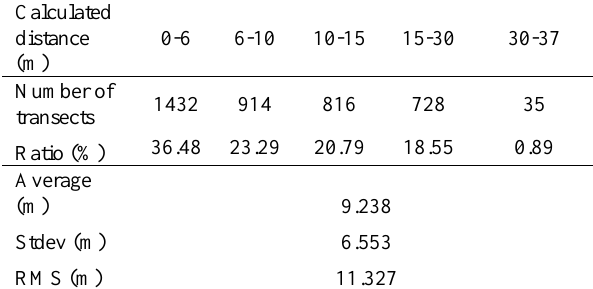
Table 3. Accuracy assessment results for LANDSAT-8.